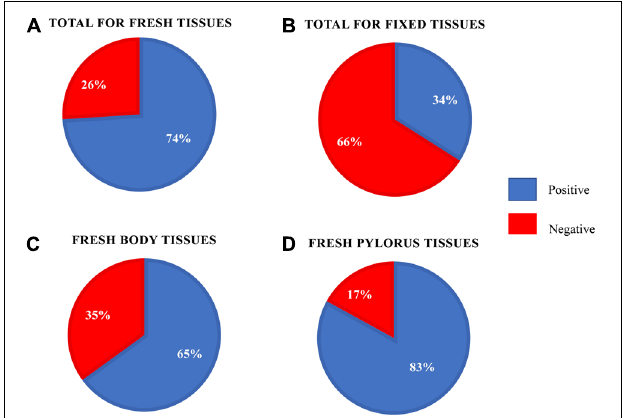
FIGURE 2 | Helicobacter quantitative PCR results for the fresh-frozen and formalin-fixed southern sea otter gastric tissue samples. (A) Results for the fresh-frozen gastric samples ( n = 92). (B) Results for the formalin-fixed paraffin embedded gastric samples ( n = 59). (C) Results for the fresh-frozen gastric body samples ( n = 46). (D) Results for the fresh-frozen gastric pylorus samples ( n = 46).